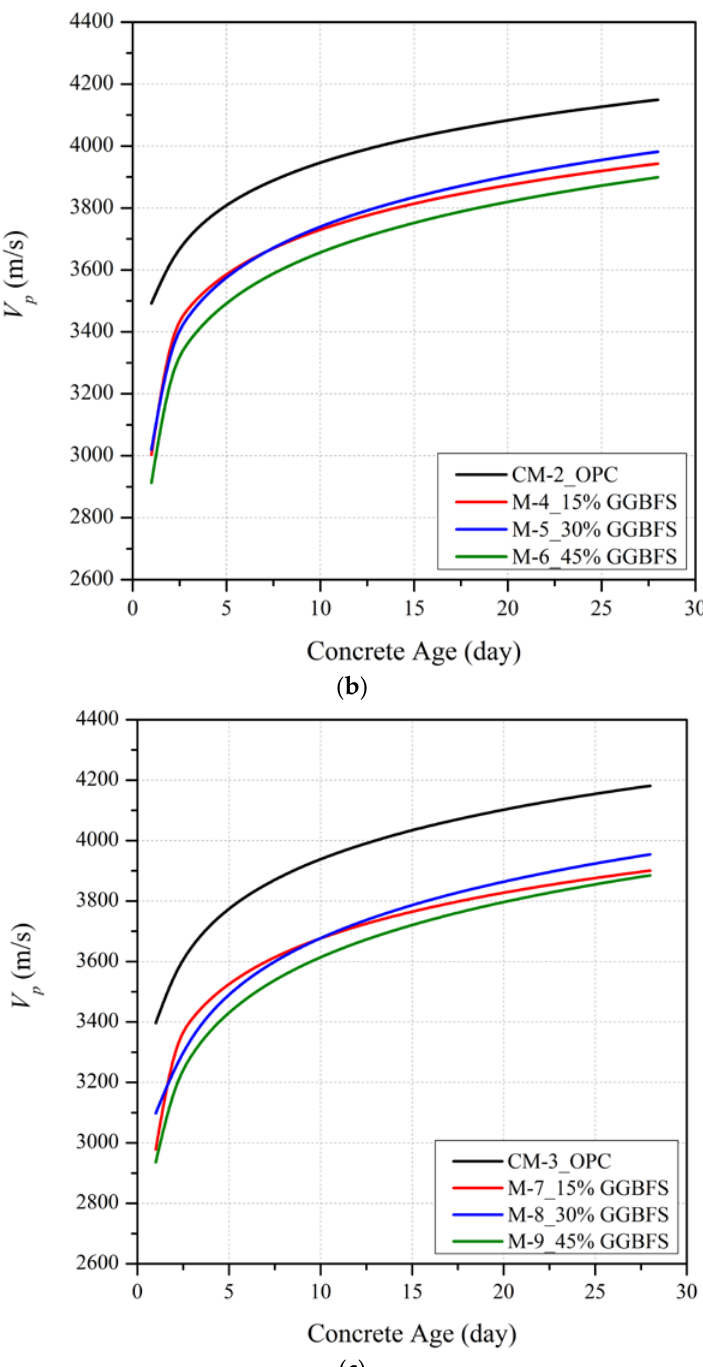
Figure 3. Ultrasonic pulse velocity development for slag blended mortar mixes with w c of ( a ) 0.4, ( b ) 0.5 and ( c ) 0.6.